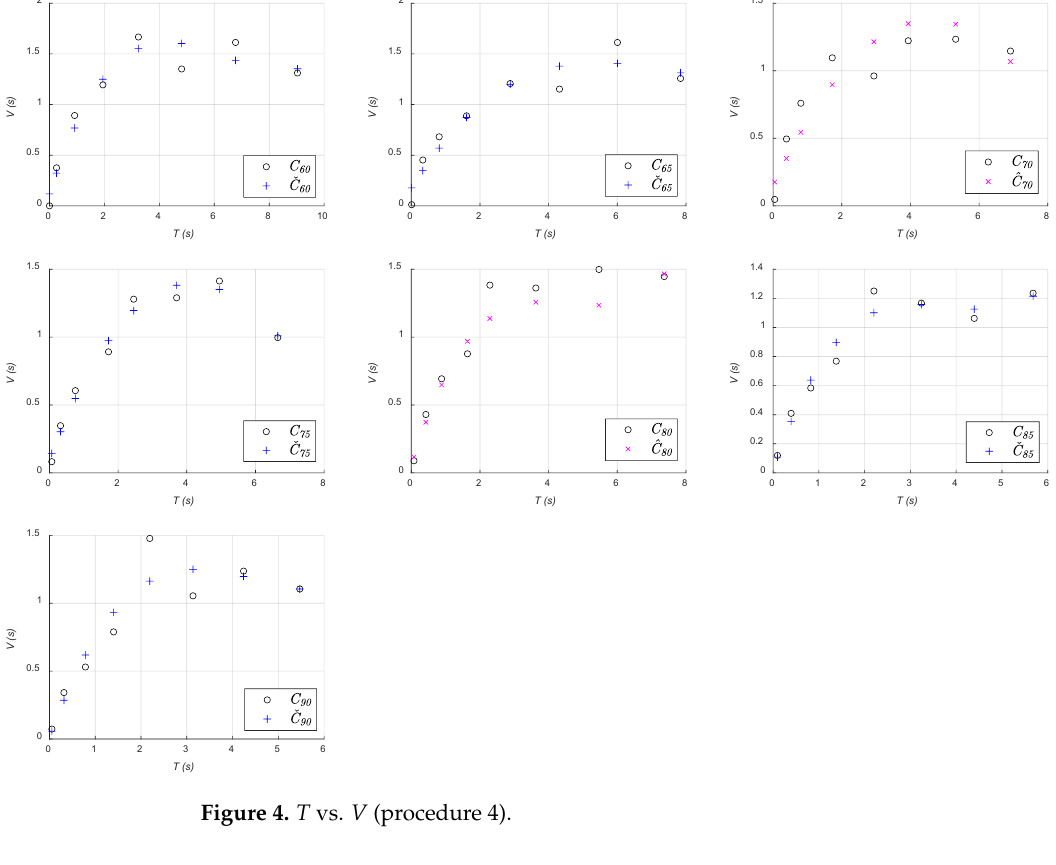
Figure 4. T vs. V (procedure 4).